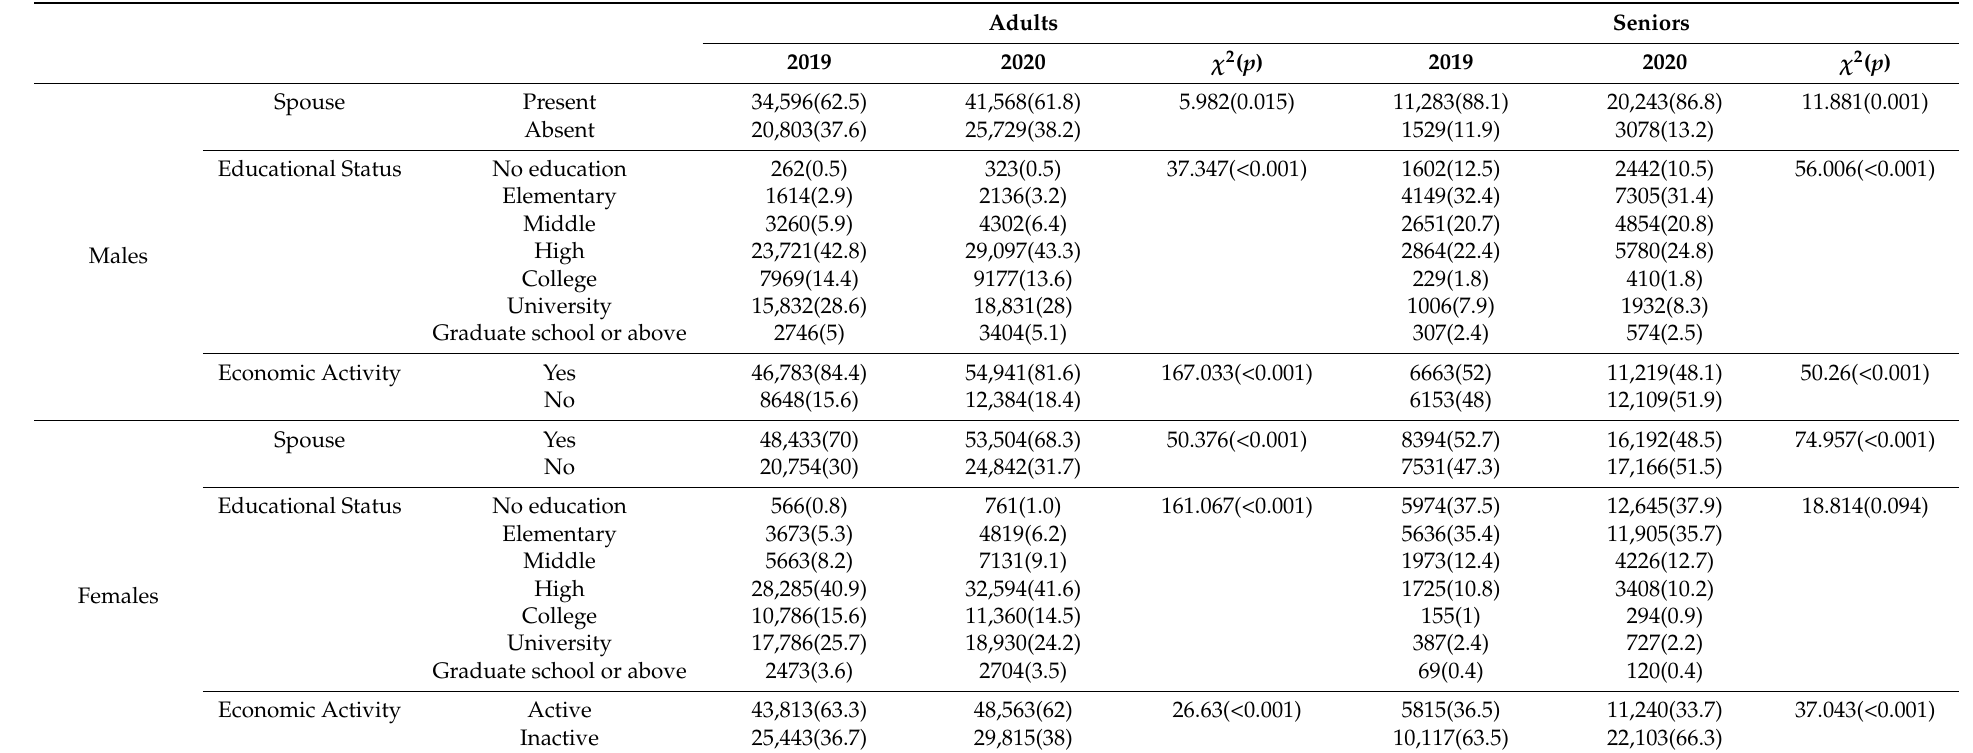
Table 1. General characteristics of